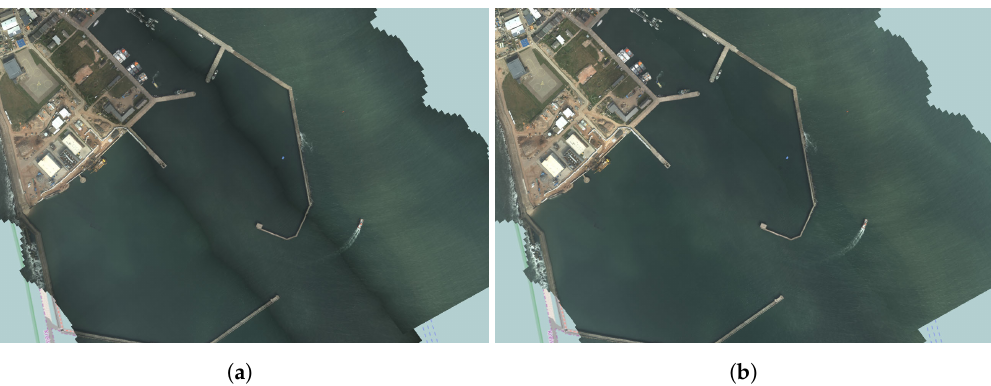
Figure 4. Effect of radiometric correction at aerial image mosaicing. ( a ) Mosaic without radiometric correction; ( b ) Mosaic with model-based radiometric